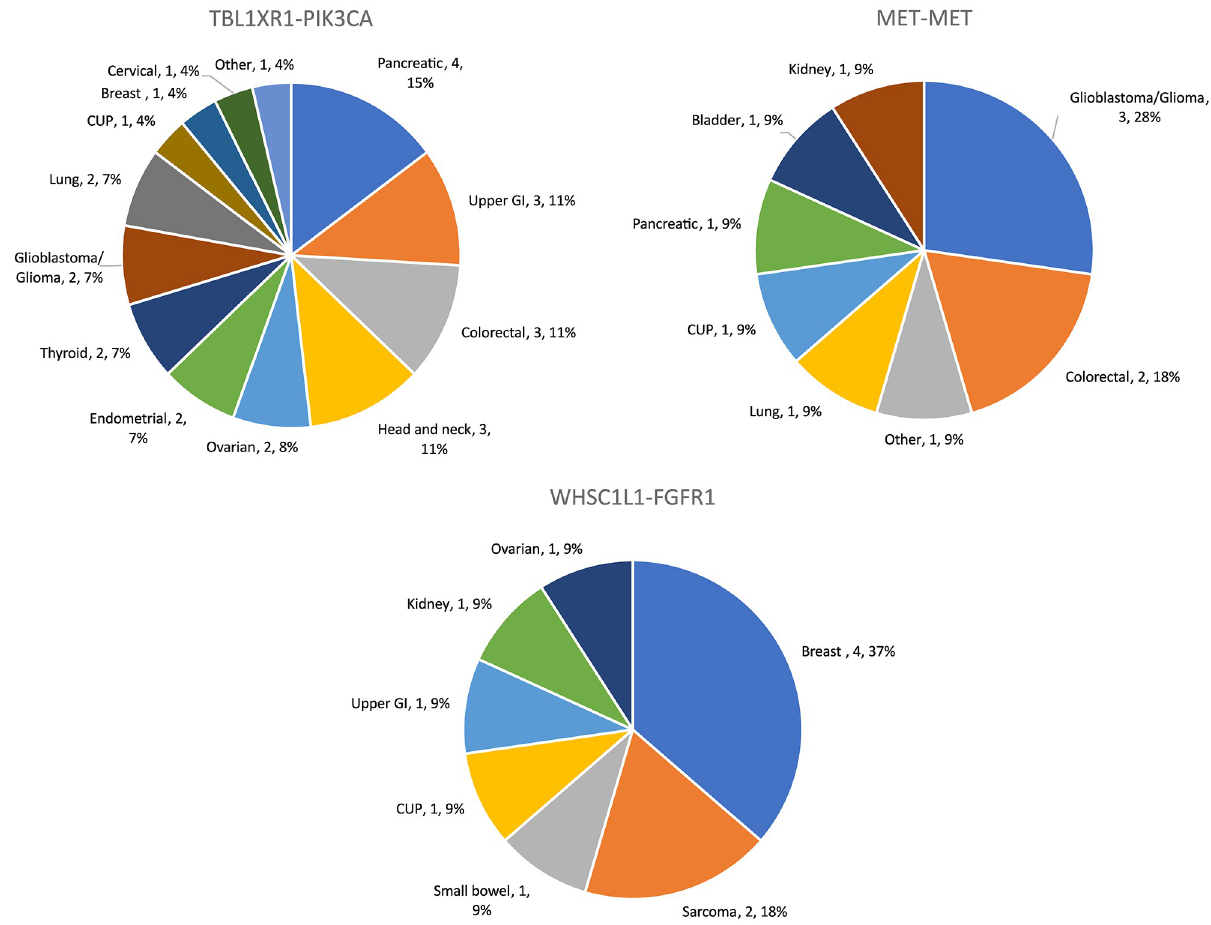
Fig 2. Frequency of the three most common actionable gene fusions in solid